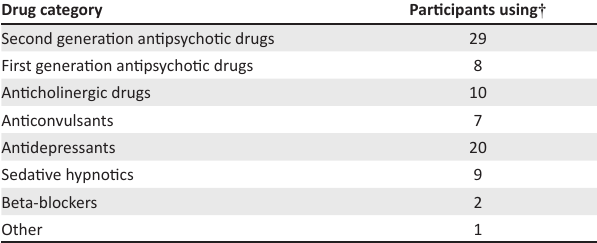
TABLE 2: Participants’ medication ( n = 30).